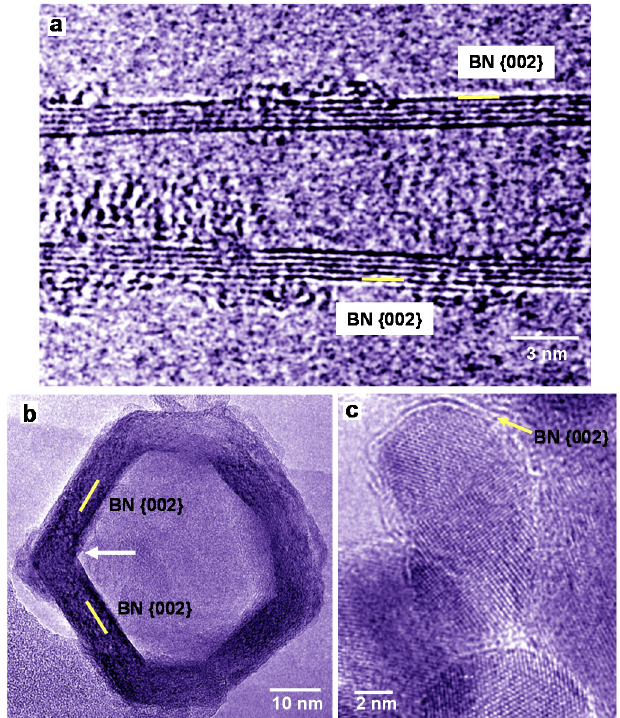
Figure 2. High-resolution electron microscopy (HREM) images of BN nanotube and BN nanocapsules produced using powder with ratios of: ( a ) La:B = 1:6; ( b ) La:B = 1:4; and ( c ) Pd:B = 1:4.